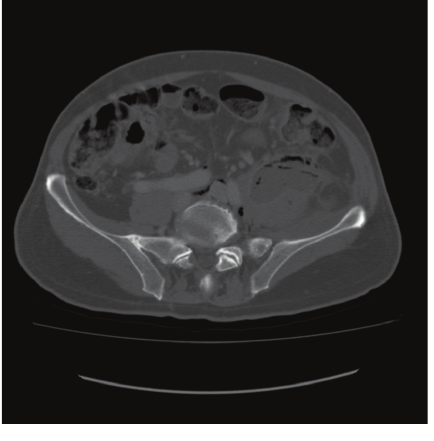
He had a 5-day history of pain in walking and in the left lower limb.